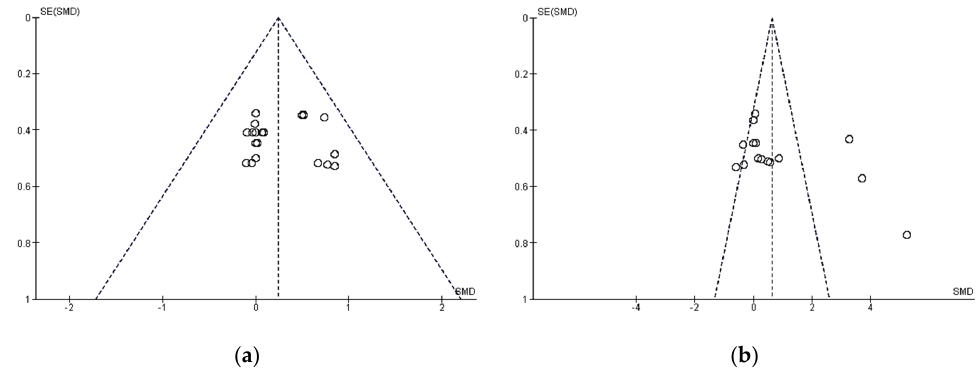
Figure 1. Funnel plot of standard error of anaerobic ( a ) and aerobic; ( b ) performance data by Hedges’ g. SE: standard error; SMD: standardized mean difference. g. SE: standard error; SMD: standardized mean di ff